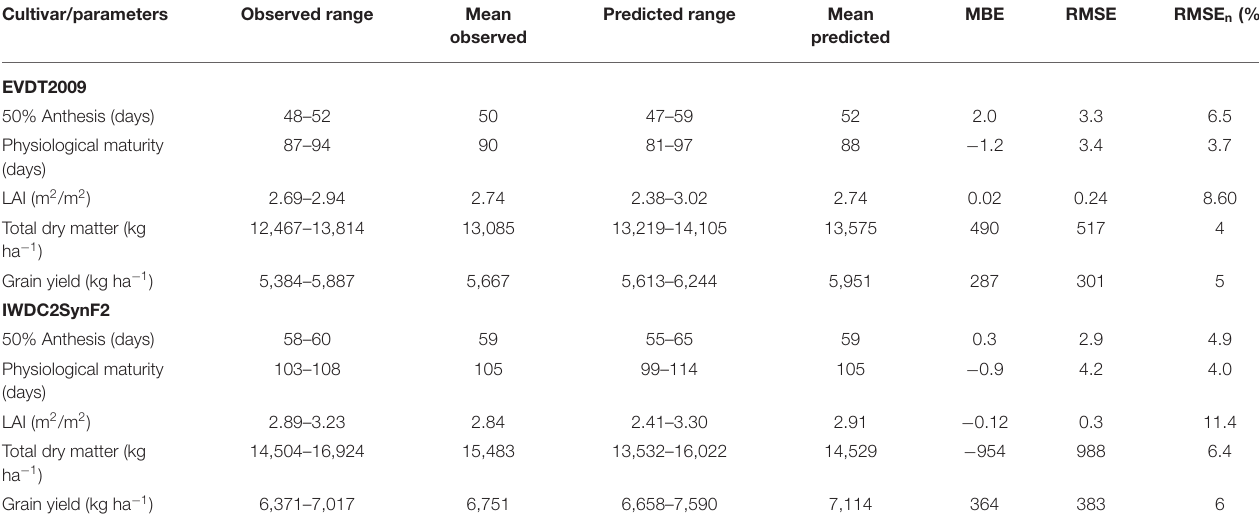
TABLE 3 | Evaluation analysis after model calibration between observed and simulated parameters for phenological development, leaf area index (LAI), total dry matter (TDM), and grain yield.